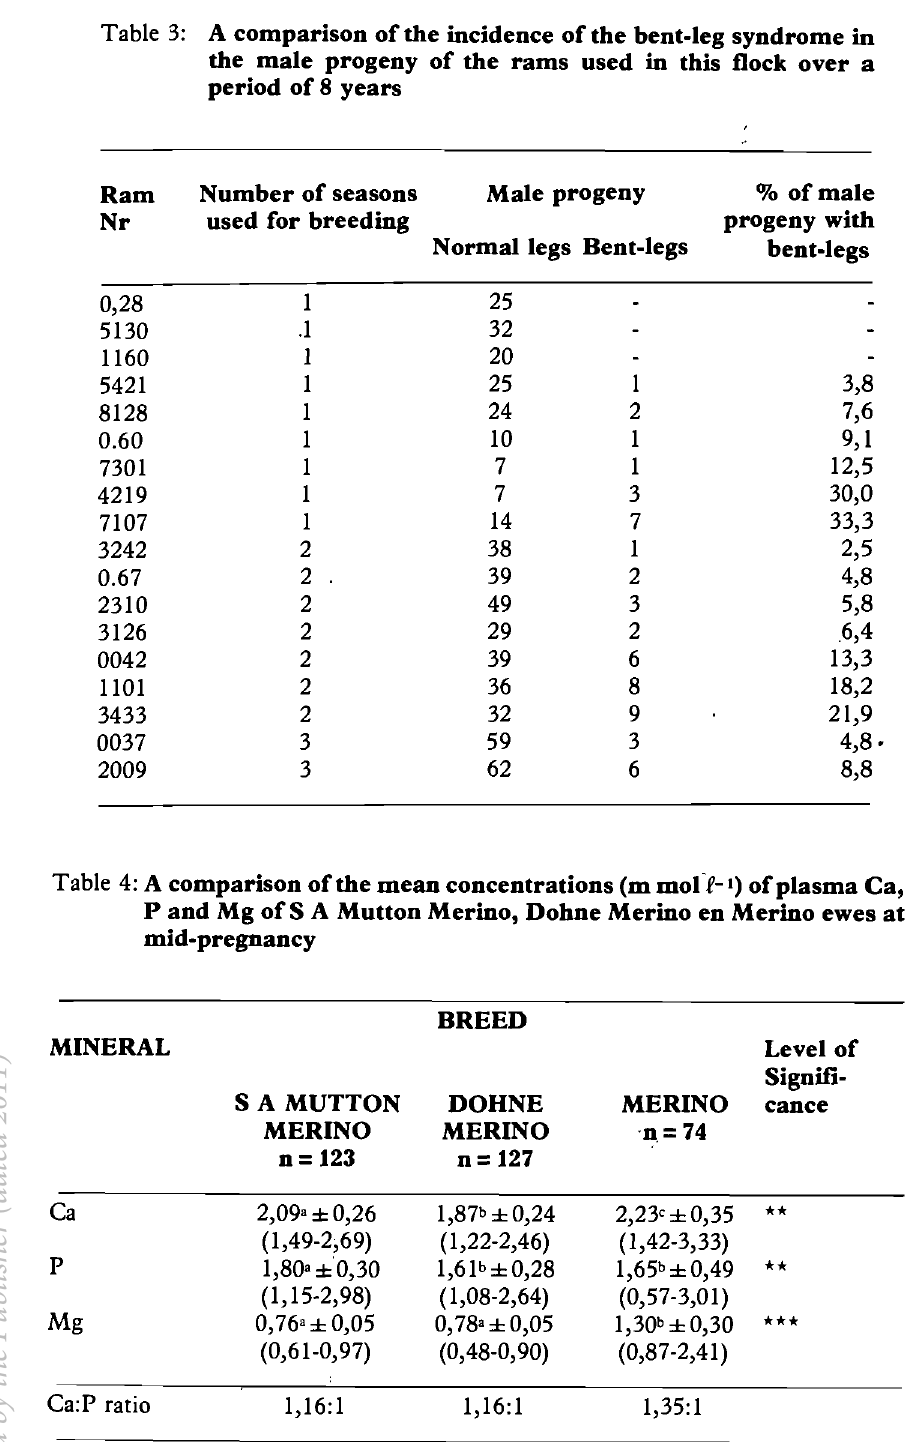
up to 33,3% (Table 3). The considerable variation in the occurrence of the bent-leg syndrome between different years, can partly be explained by the contributing effect of these specific rams which further emphasises the possibility of a genetic background. Although S A Mutton Merino ewes had higher plasma P concentrations at mid pregnancy (Table 4) than those of the other 2 breeds, these concentrations were